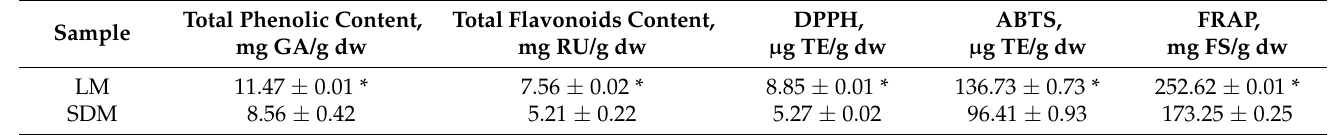
Table 5. Total phenolics, flavonoids content and antioxidant activity of microcapsules.